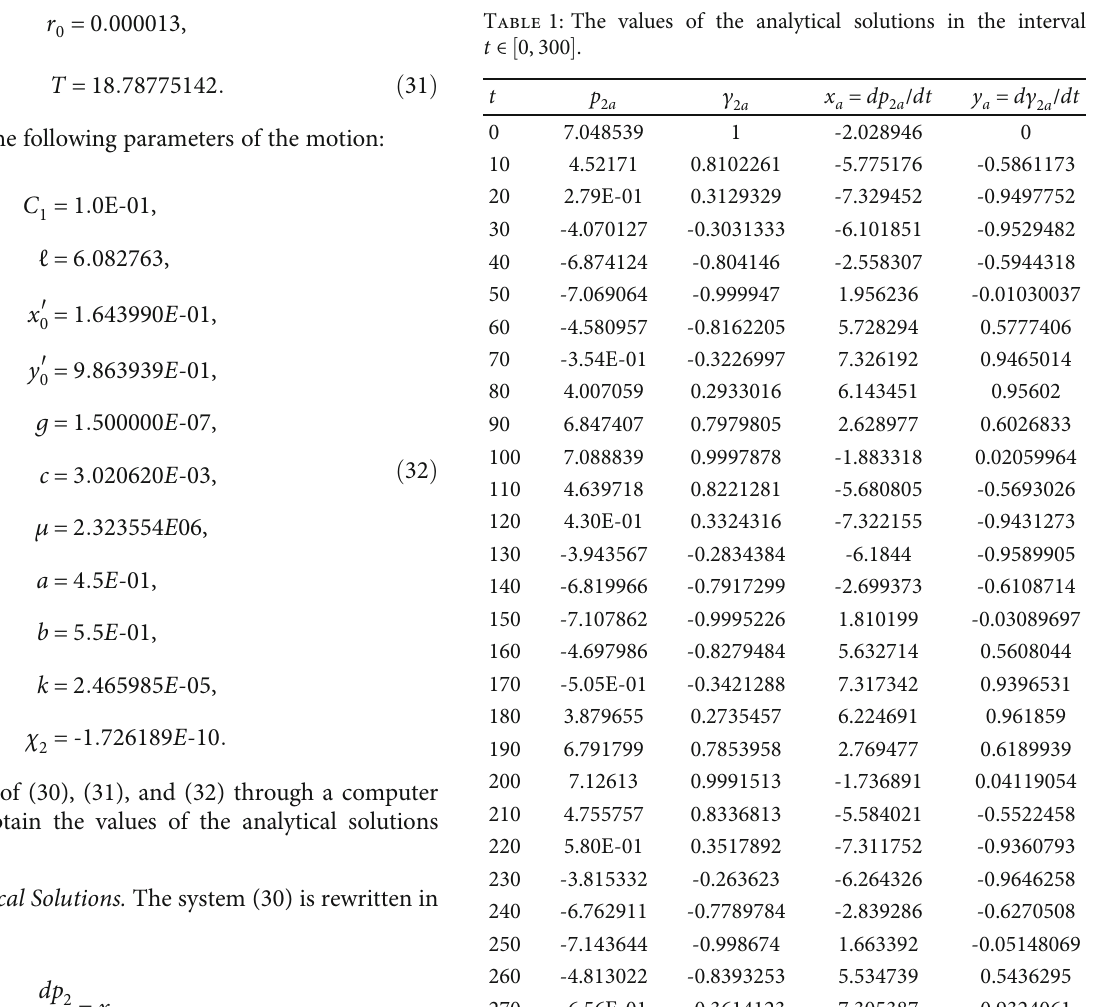
Table 1: The values of the analytical solutions in the